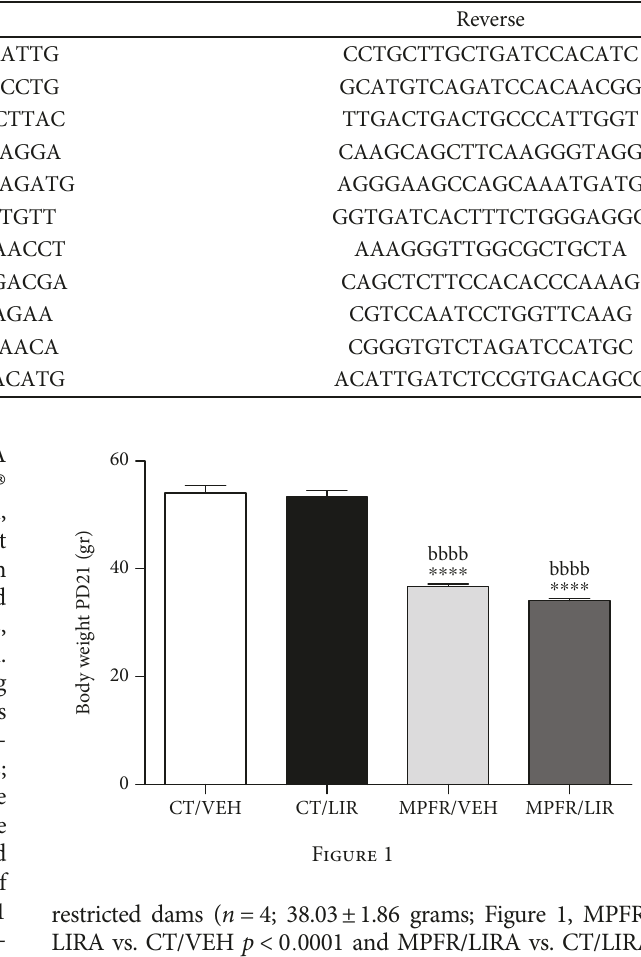
Table 1: Primer sequences used for quantitative real-time polymerase chain